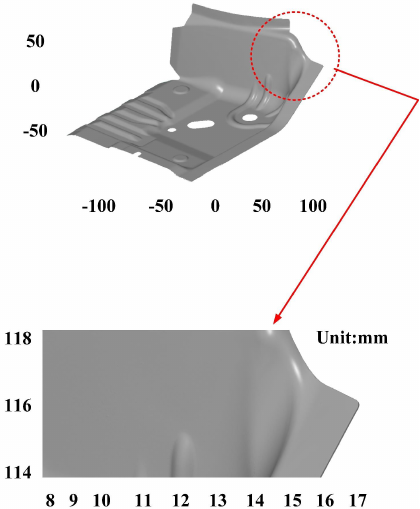
Figure 12. Measurement results of the glossy sheet metal that was sprayed with a mixture of TiO 2 powder and ethanol before optical measurements.